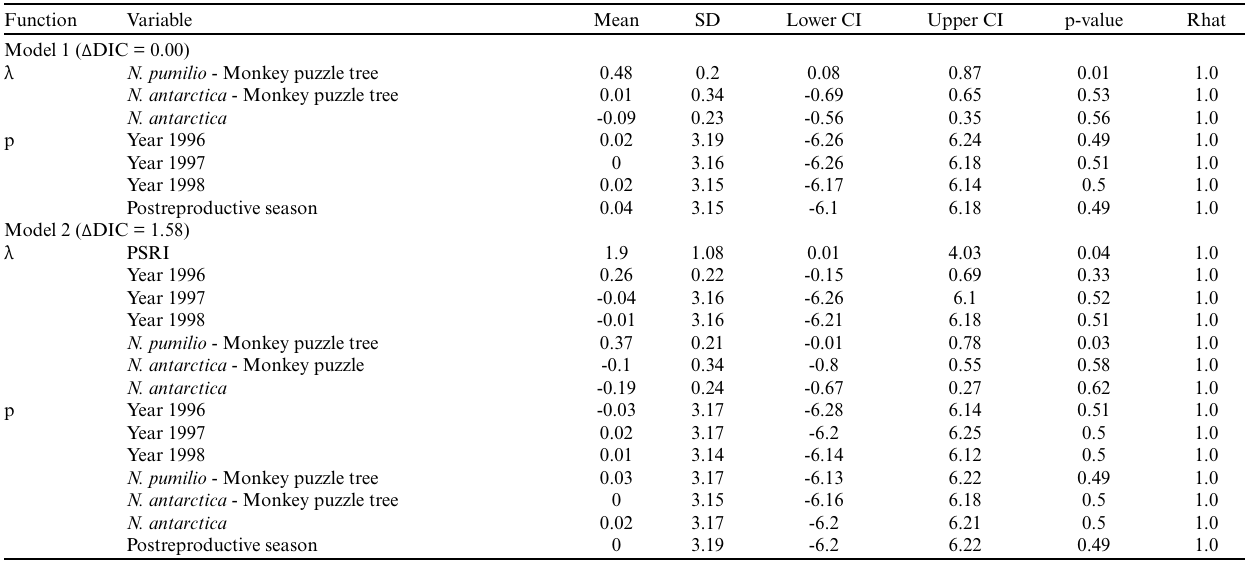
Table 3 . Coefficients from the two best-supported Bayesian N-mixture CAR models explaining the abundance of Magellanic Woodpeckers ( Campephilus magellanicus ) in the studied national parks. The mean, standard deviations (SD), p-value, and 95% lower and upper Bayesian credible intervals (CI) are presented. For comparison reasons, coefficients for Year 2016, reproductive season and forest of N. dombeyi - Monkey puzzle tree were set to be zero.